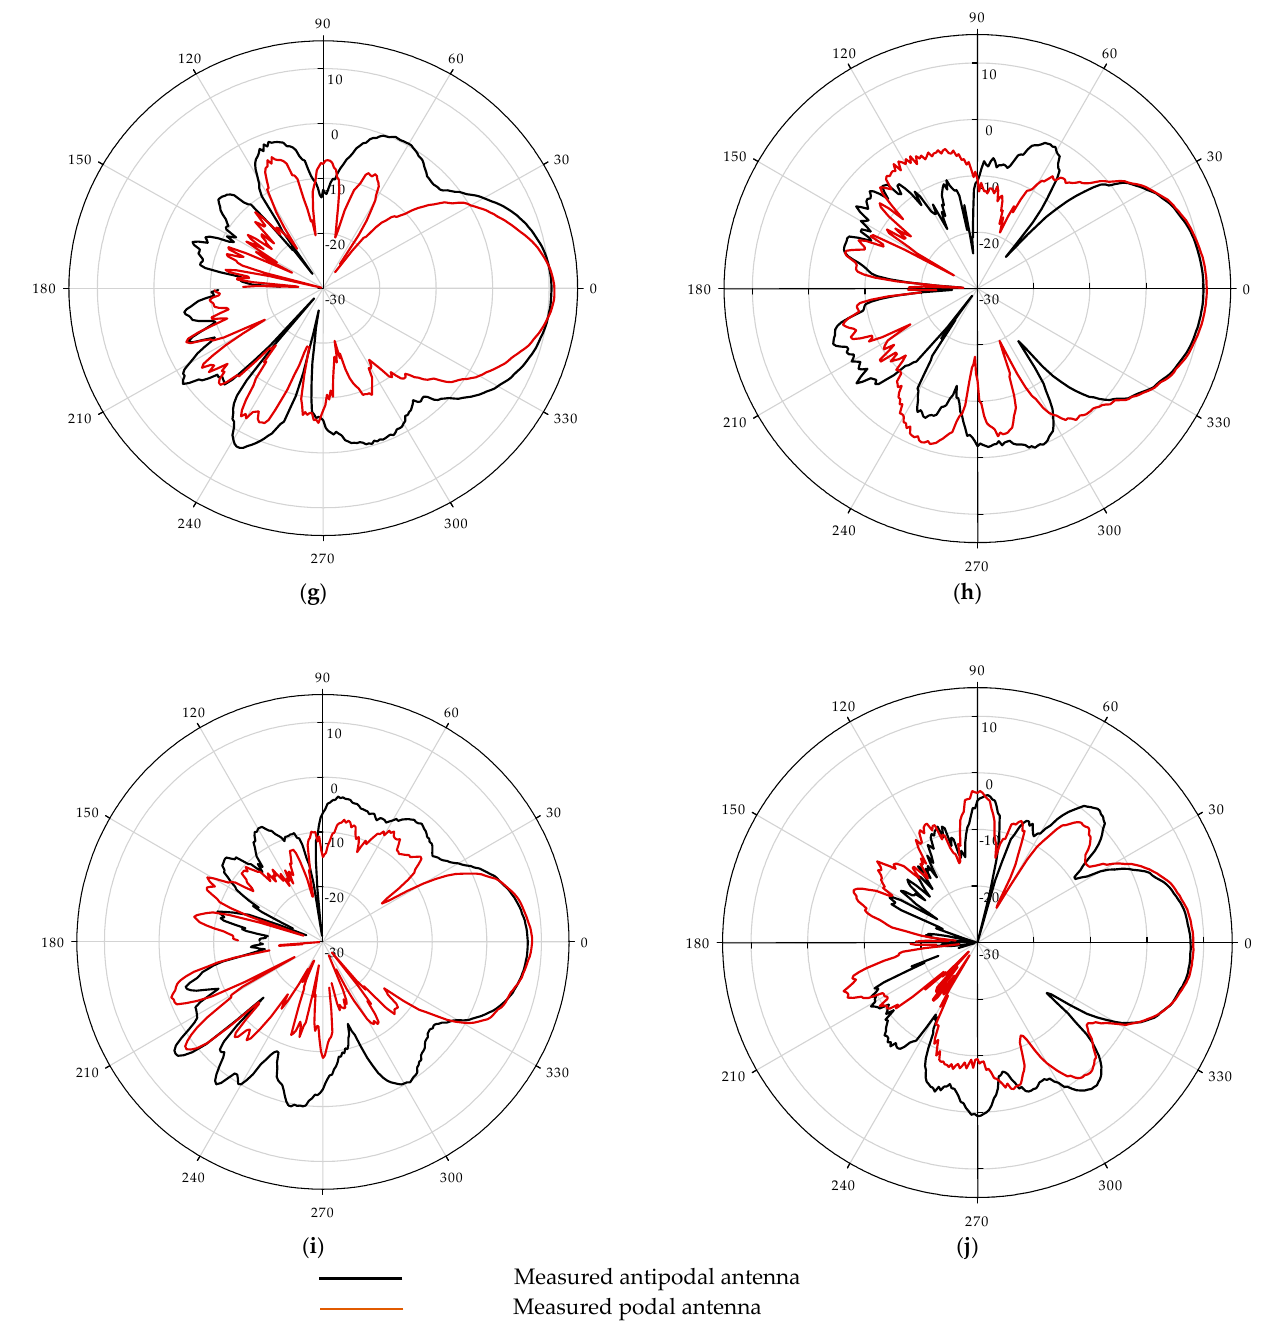
Figure 5. Measured far-field radiation pattern at E-plane ( a , c , e , g , i ) and H-plane ( b , d , f , h , j ) at frequency 5, 6, 8, 10, and 13 GHz respectively.